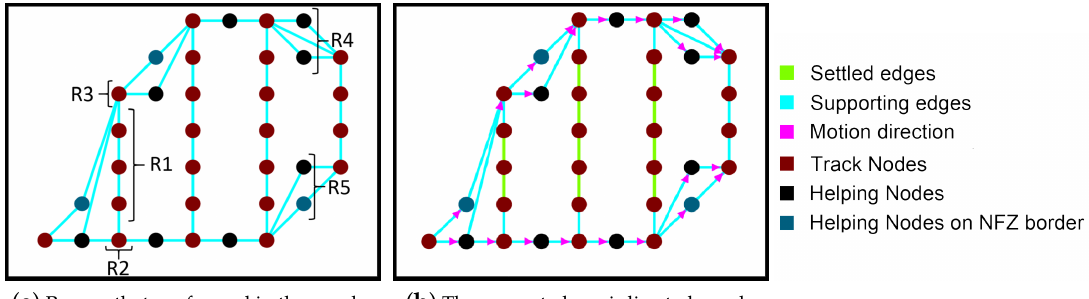
( b ) The generated semi-directed graph. Figure 8. Edges creation: connecting vertices according to the